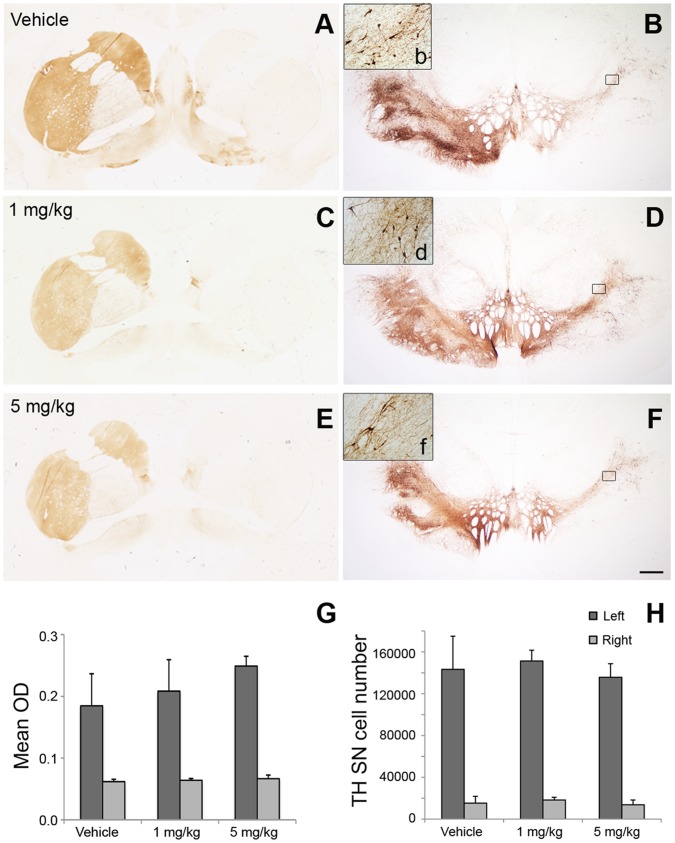
Tyrosine Hydroxylase (TH) expression is not affected by HIRmAb-GDNF.(A to F) Coronal images of the TH immunostained striatum at the level of the anterior commissure (A, C, and E) and of the substantia nigra at the level of the red nucleus (B, D, and F) of monkeys treated with vehicle (A and B), 1 mg/kg (C and D), or 5 mg/kg (E and F) HIRmAb-GDNF. Scale bar: 2.5 mm (A, C, and E); 1 mm (B, D, and F); 110 µm (insets b, d, and f). (G) Average TH optical density (OD) in the caudate and putamen nucleus. (H) Stereological cell counts of TH-positive neuron cells in the substantia nigra (SN).